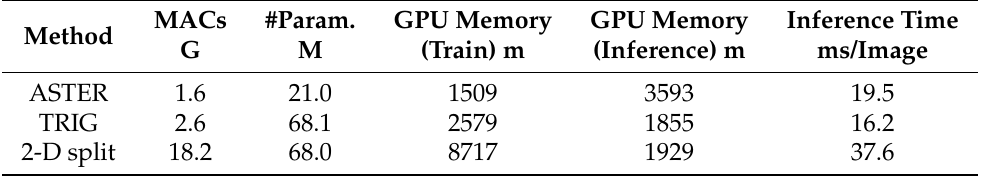
Table 4. Efficiency comparison between ASTER and TRIG. MACS, model parameters, gpu memory cost, and speed are